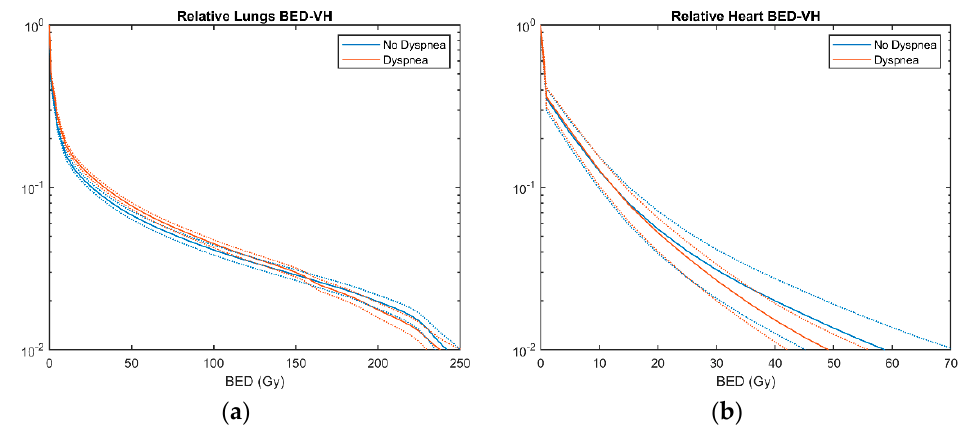
Figure 1. Average Biologically Effective Dose (BED) ‐ Volume Histograms ± SEM (Standard Error of the mean) of patients developing any grade dyspnea and who did not.